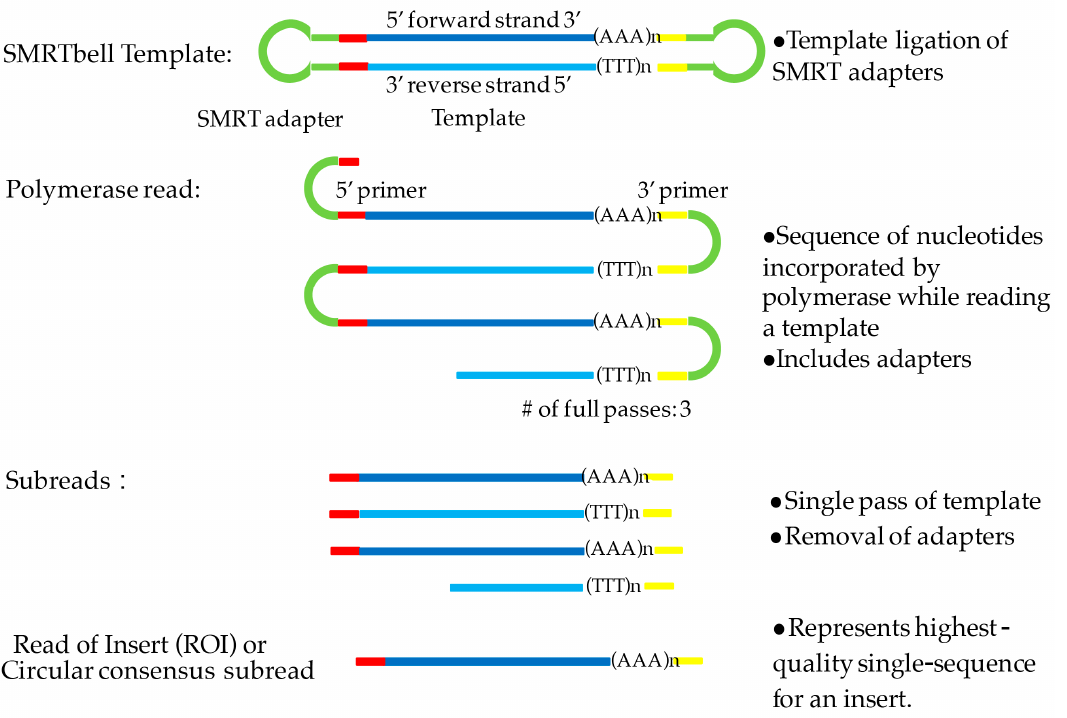
Figure 1. Definition of the polymerase read, subreads, and the read of insert (ROI). DNA template is labeled in blue and adapter in green. SMRT: Single-Molecule Real-Time sequencing.